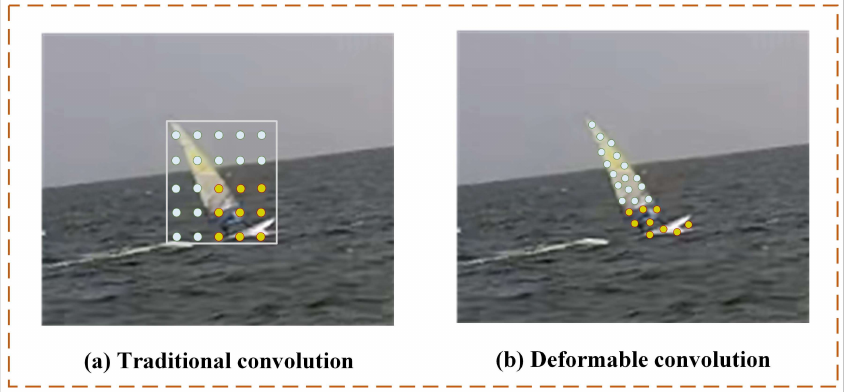
Figure 2. Schematic diagram of different convolution